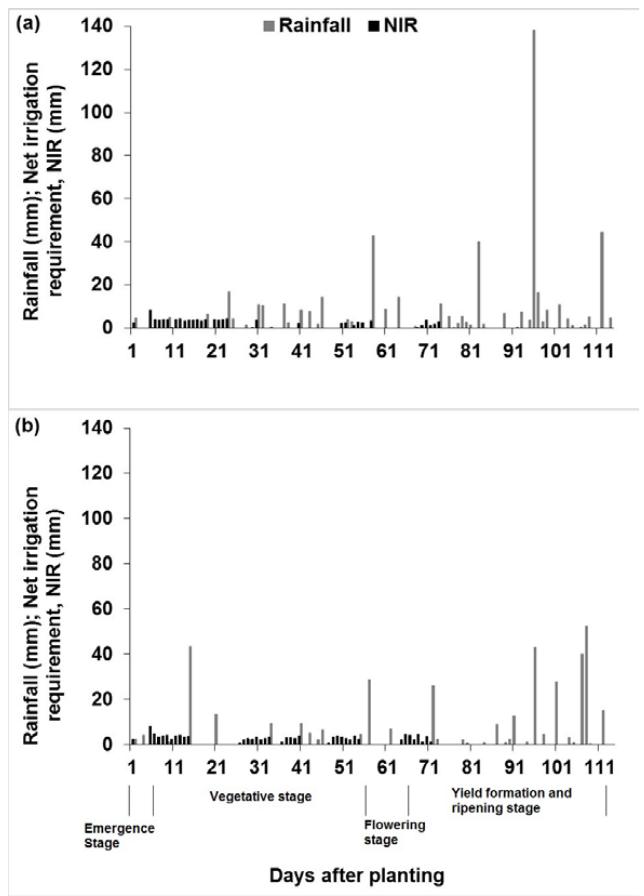
Figure 12. Daily rainfall and net irrigation requirement for supplemental irrigation of maize in the ( a ) 1999 wet year and ( b ) 2012 dry year, as simulated in AquaCrop based on the example of maize BF1 in the Bongo irrigation scheme.